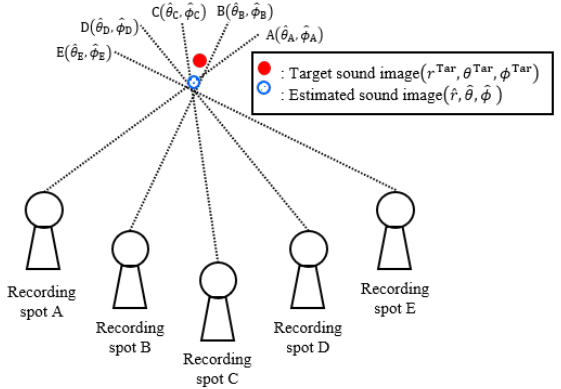
Figure 10. Estimation of the position of the reconstructed 3-D sound image ( ˆ r , ˆ θ , ˆ φ )